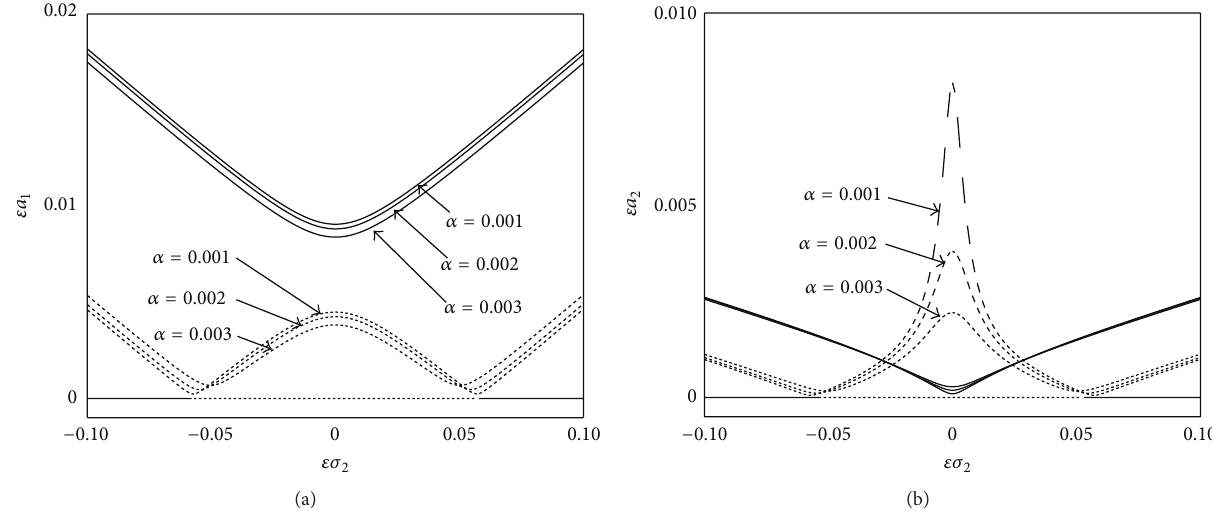
Figure 10: Amplitude-frequency curves of the summation resonance for different viscosity coefficients: (a) the first mode and (b) the second mode.